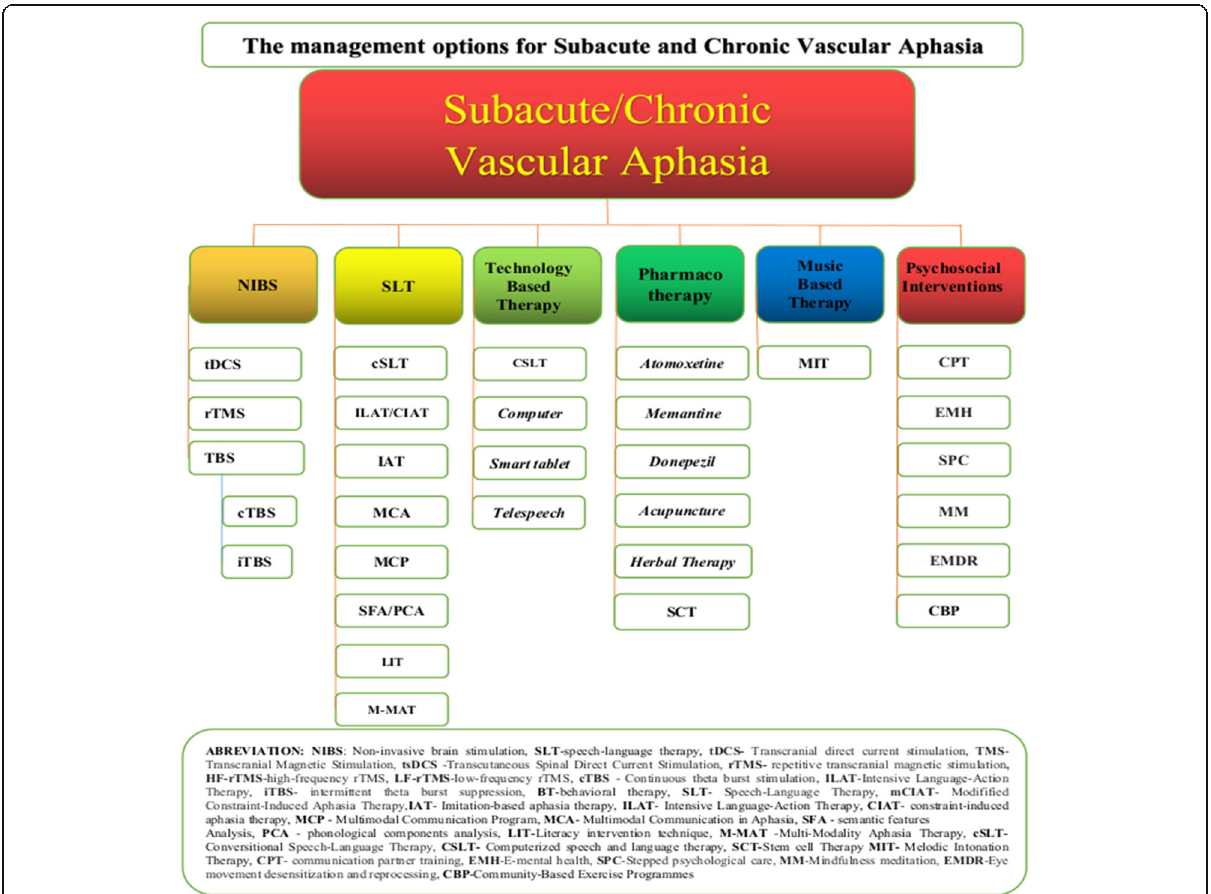
Fig. 1 Compiling six major choices and 30 sub-options for management of chronic and subacute vascular aphasia based on English studies from PubMed search (2016 through 2020), the last row highlights the abbreviated